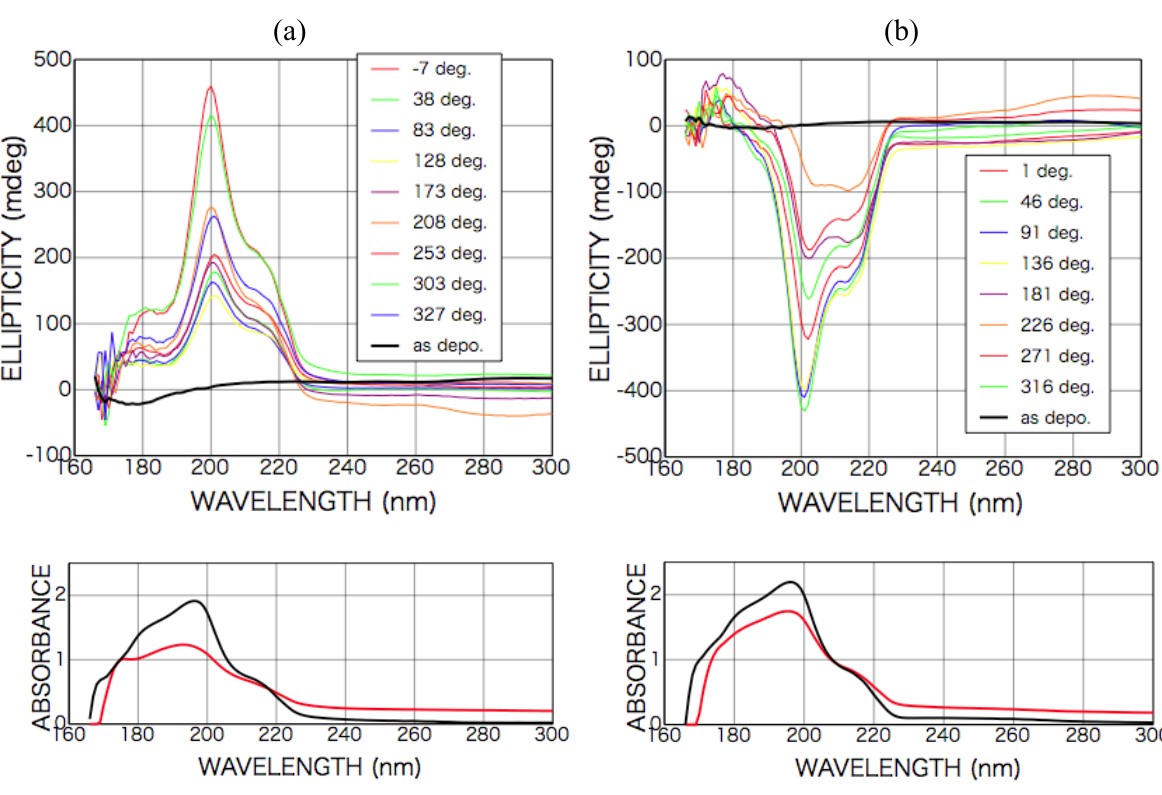
Figure 7. CD and photo absorption spectra of DL -phenylalanine films as-deposited (black) (200-nm in thickness) and after CPL irradiation (colored). (a) Left-handed CPL; (b) right- handed CPL. Dependence on the sample rotation angle θ is also